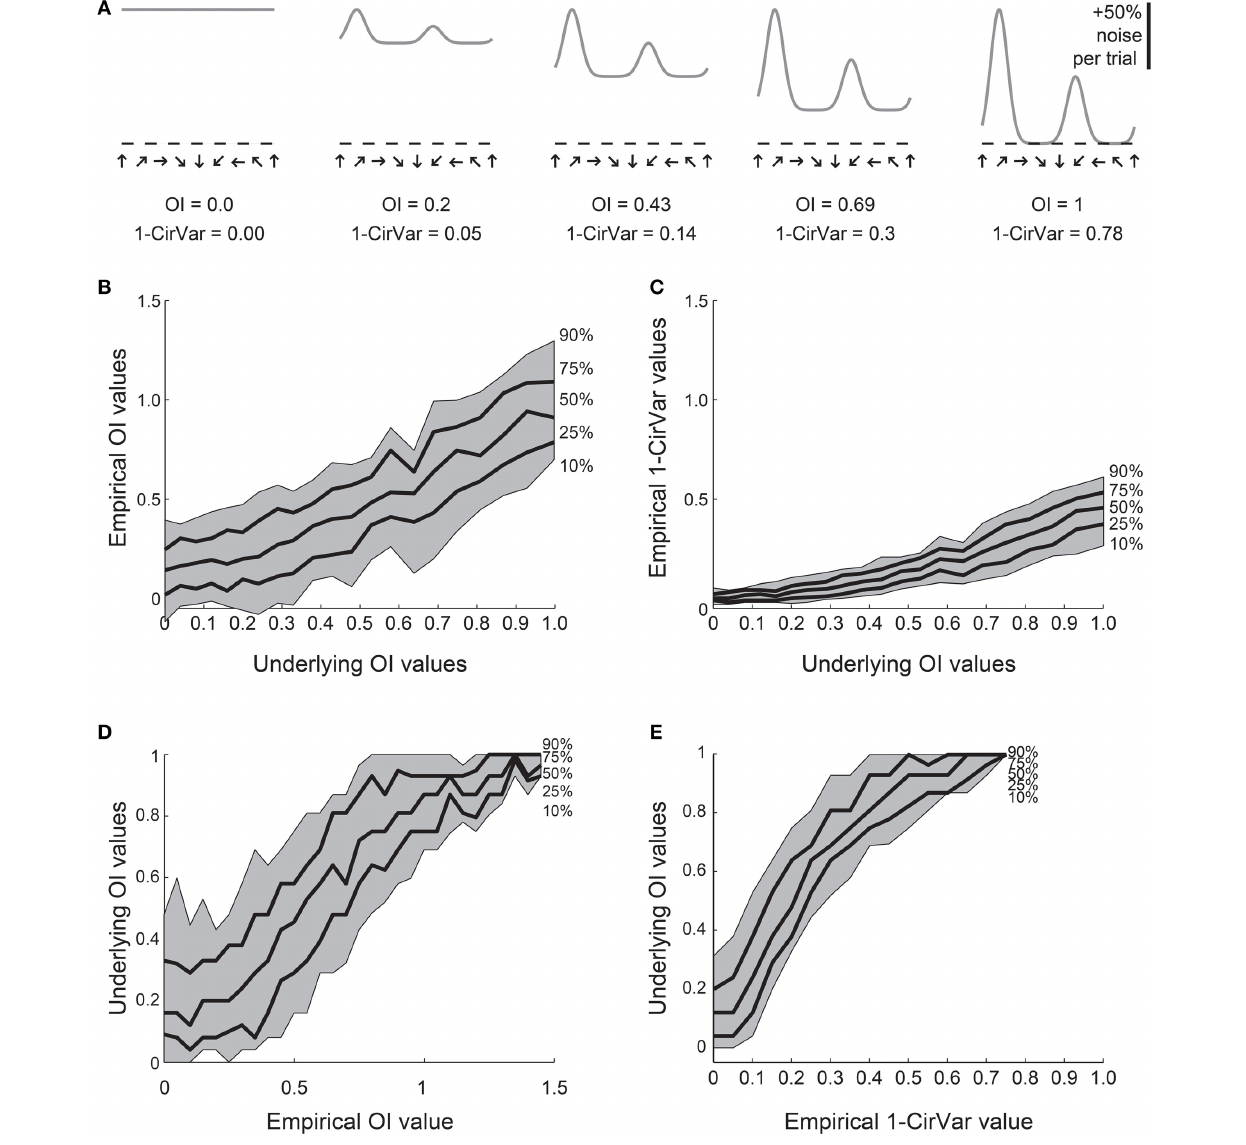
corresponding range of empirical OI values in (B) . (D) The inverse of (B) ; given we observed an empirical OI value of x, what is the range of possible “true” OI values that produced x in our simulations? An empirical OI of 0 could have arisen from cells with “true” OI values ranging from 0 to 0.5, and an empirical OI of 0.5 could have arisen from cells with a “true” OI ranging from about 0.1 to about 0.8. (E) The inverse of (C) . A 1- CirVar of 0 could have arisen from a “true” OI ranging from 0 to about 0.3, and 1- CirVar of 0.25 could have arisen from a “true” OI ranging from about 0.4 to 0.8. The range of possible underlying “true” OI values is much narrower when 1- CirVar is used as a readout as compared to OI